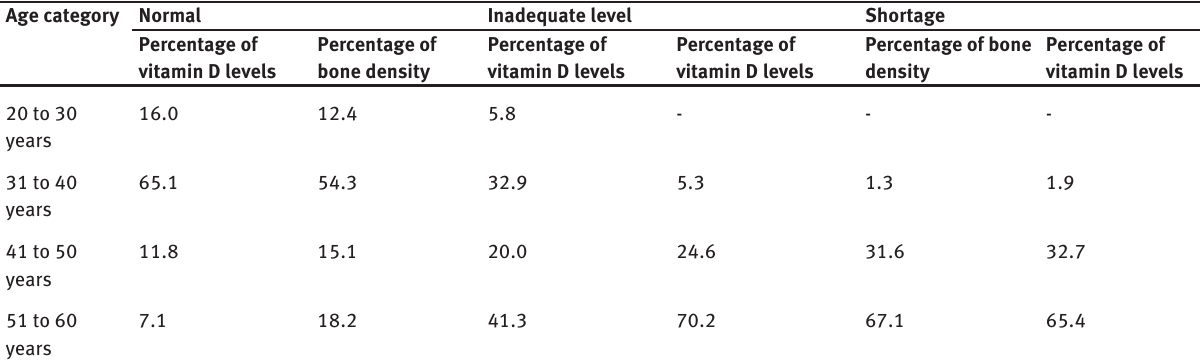
Table 1: Distribution of vitamin D level and bone density in patients referred to the Bone Density Clinic in the Kowsar Hospital of Semnan during 2017 by age group.